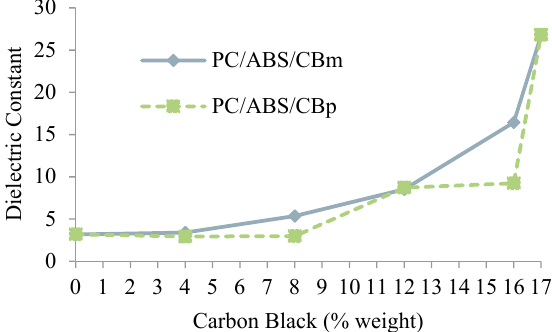
Figure 9. The relationship between dielectric constant and percentage of carbon black.